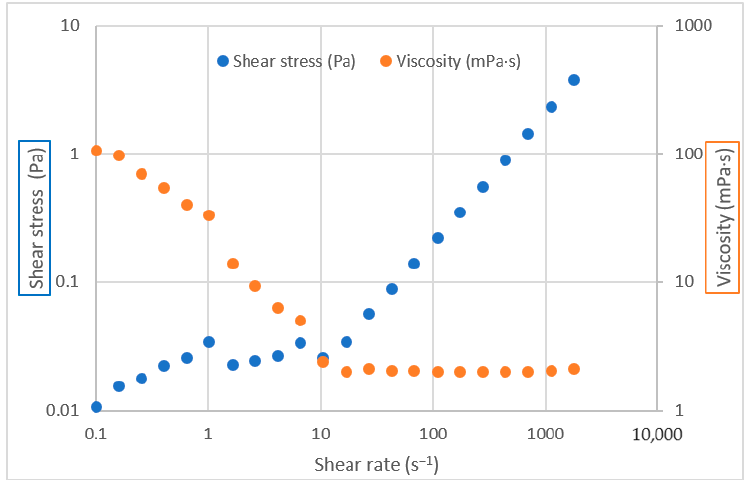
Figure 4. Rheological properties of the sterile water sample.